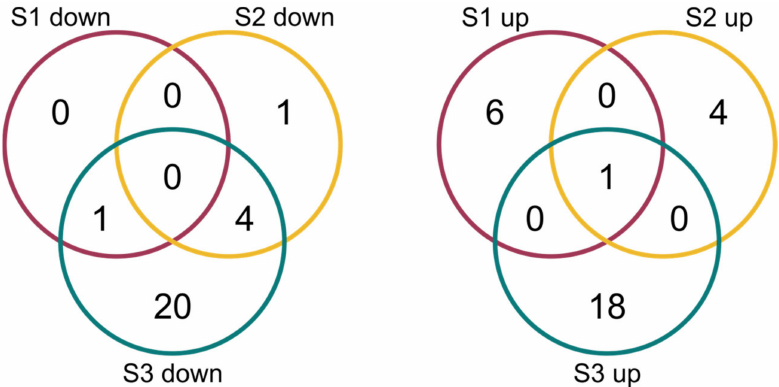
Figure 5. Venn diagrams of differentially expressed miRNAs in three cucumber somaclonal lines (S1, S2 and S3) in comparison to B10